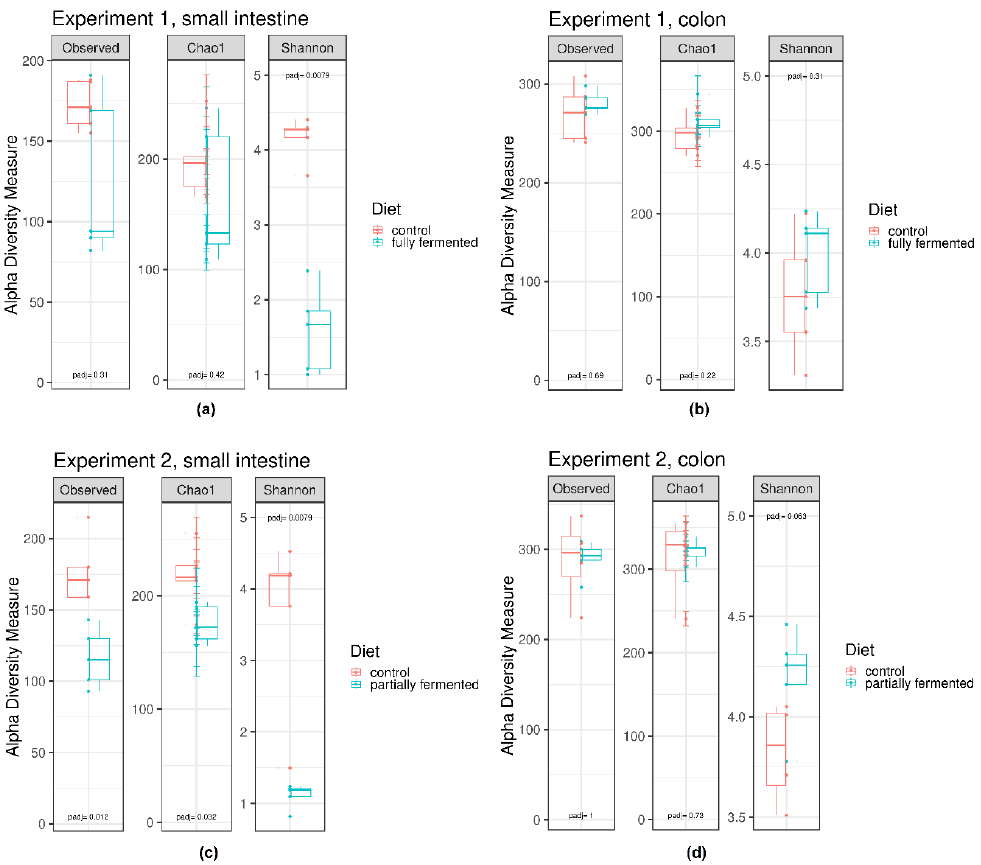
Figure 1. Alpha diversity in intestinal contents depending on the experiment, sampling point and dietary treatment. Box plots showing alpha diversity in samples using the species richness estimators of the Observed Species, Chao1 and Shannon indices. Comparisons of the species richness estimators were done by the Wilcoxon rank sum test with p -value adjustment method: holm. ( a ) Experiment 1, small intestine; ( b ) Experiment 1, colon; ( c ) Experiment 2, small intestine; ( d ) Experiment 2, colon.